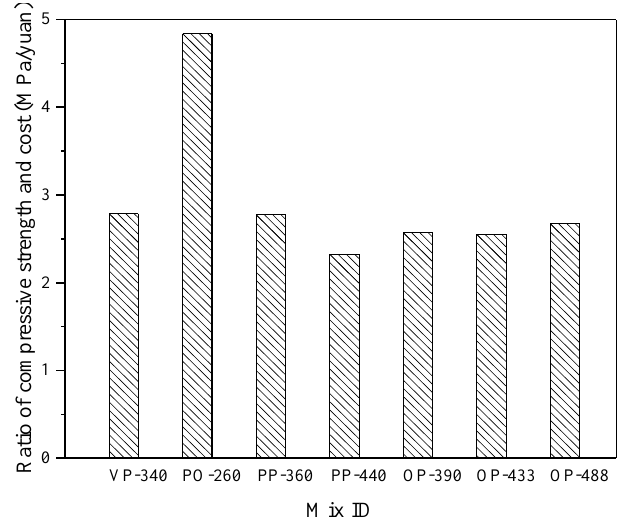
Figure 8. Comparison of strength cost ratio of the artificial rockfills.